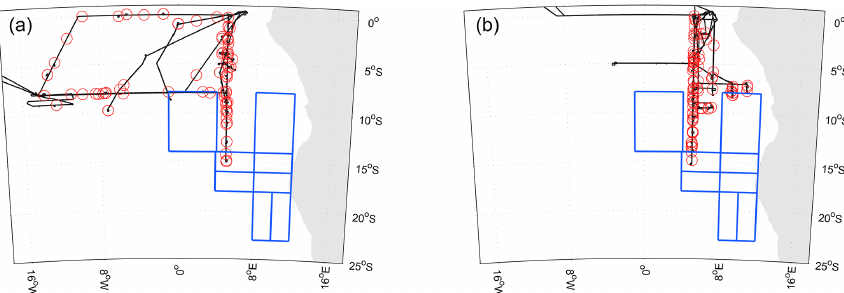
Figure 14. Map showing the flight tracks of (a) the 12 science flights + 2 transit flights by the P-3 in ORACLES-2017 and (b) the 13 science flights + 2 transit flights by the P-3 in ORACLES-2018. The blue boxes give the regional subsets used in Fig. 1 and Sect. 3.3, which highlight the difference in spatial sampling between 2017–2018 and 2016. While few flights in these years fell within these boxes, quite a few (including the routine flight path) were within the 7.75 to 14 ◦ S latitude range shown in Figs. 9 and 10. Note that while the routine flights in 2016 followed a SE-to-NW diagonal, the routine flight path in the 2 later years was N–S along 5 ◦ E.